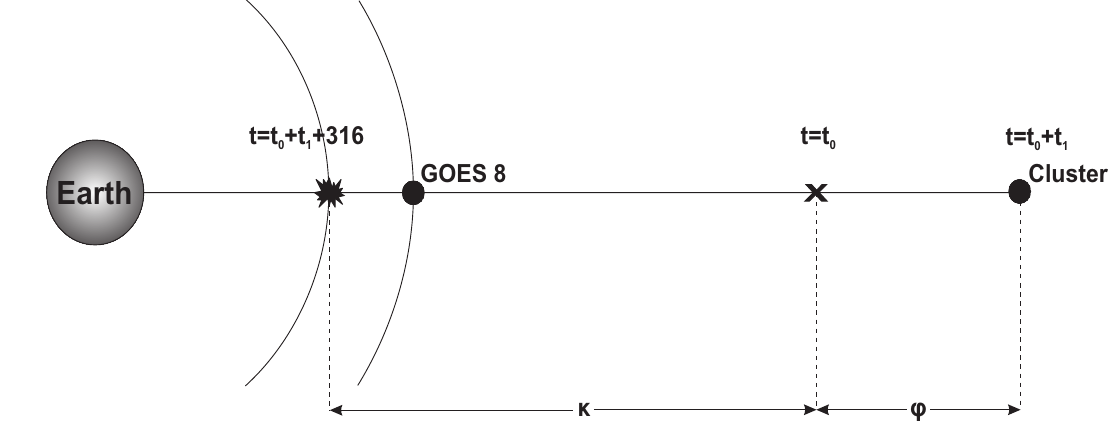
Fig. 14. Schematic diagram illustrating the relative times and distances used in the calculations.